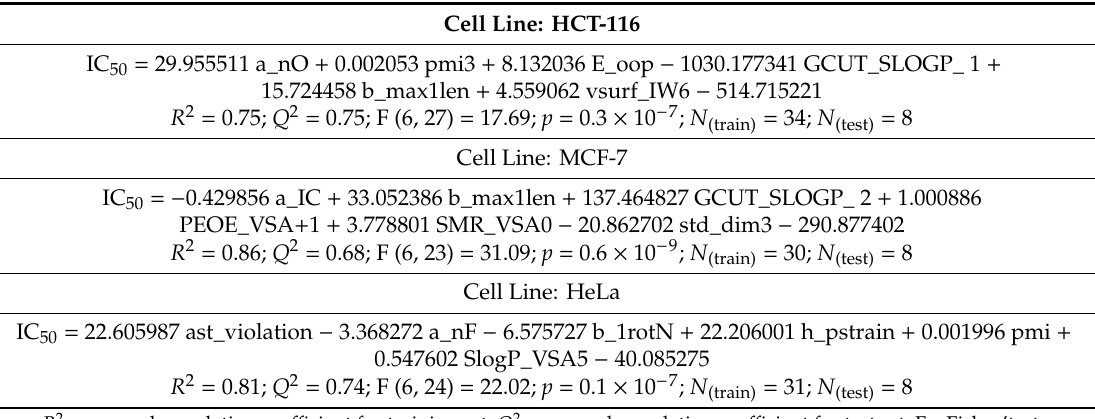
Table 2. Summary of the QSAR